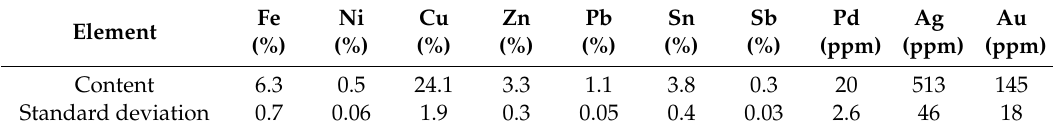
Table 5. Elemental composition of shredded printed circuit boards.